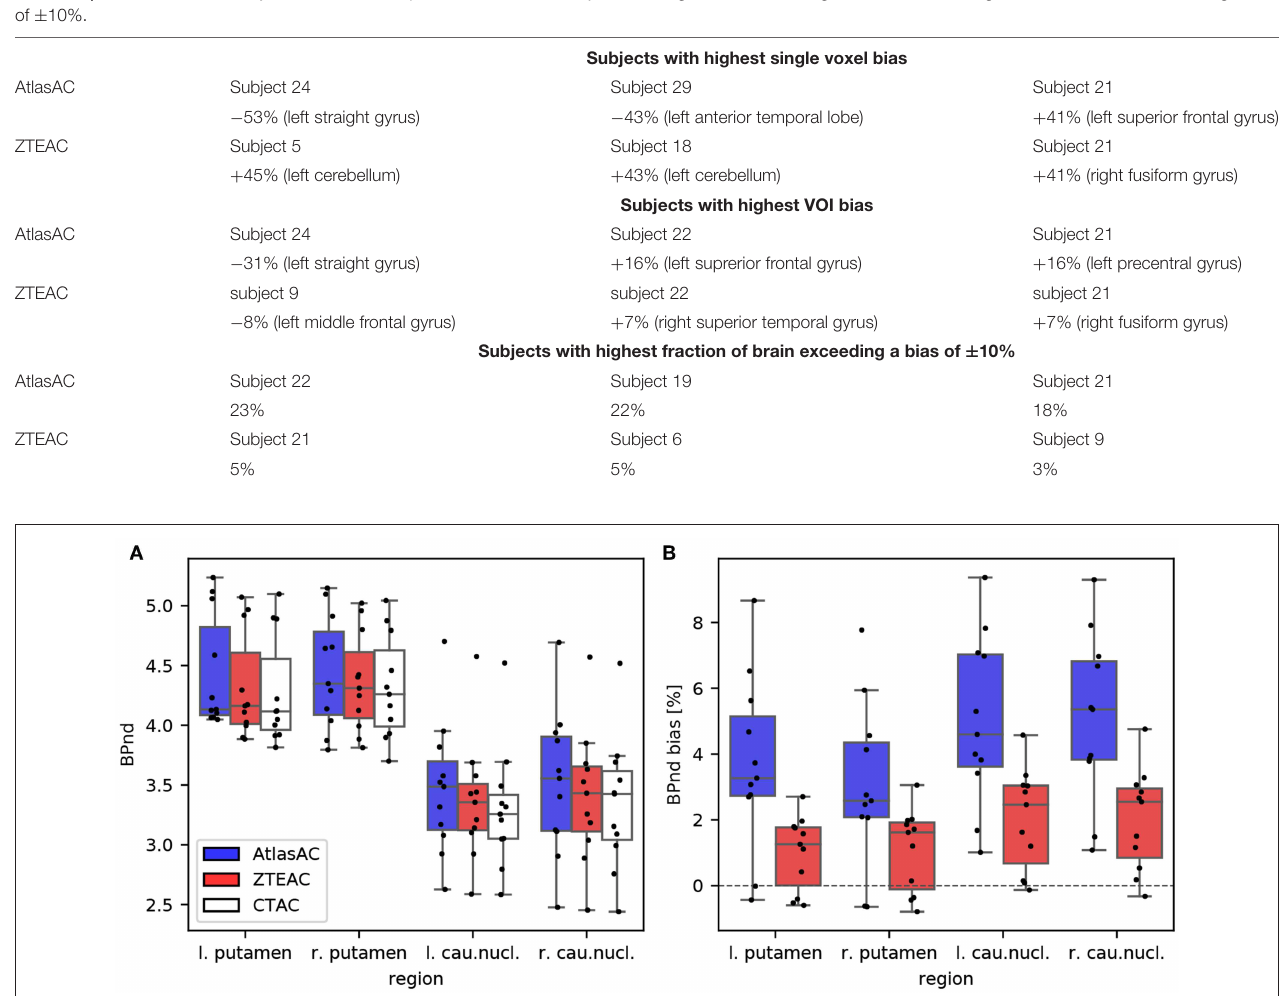
FIGURE 7 | (A) Boxplot of BP nd values in four striatal regions of the 11 [ 18 F]PE2I subjects obtained from PET AtlasAC , PET ZTEAC , and PET CTAC . (B) Bias in BP nd estimation in PET AtlasAC , PET ZTEAC compared to PET CTAC